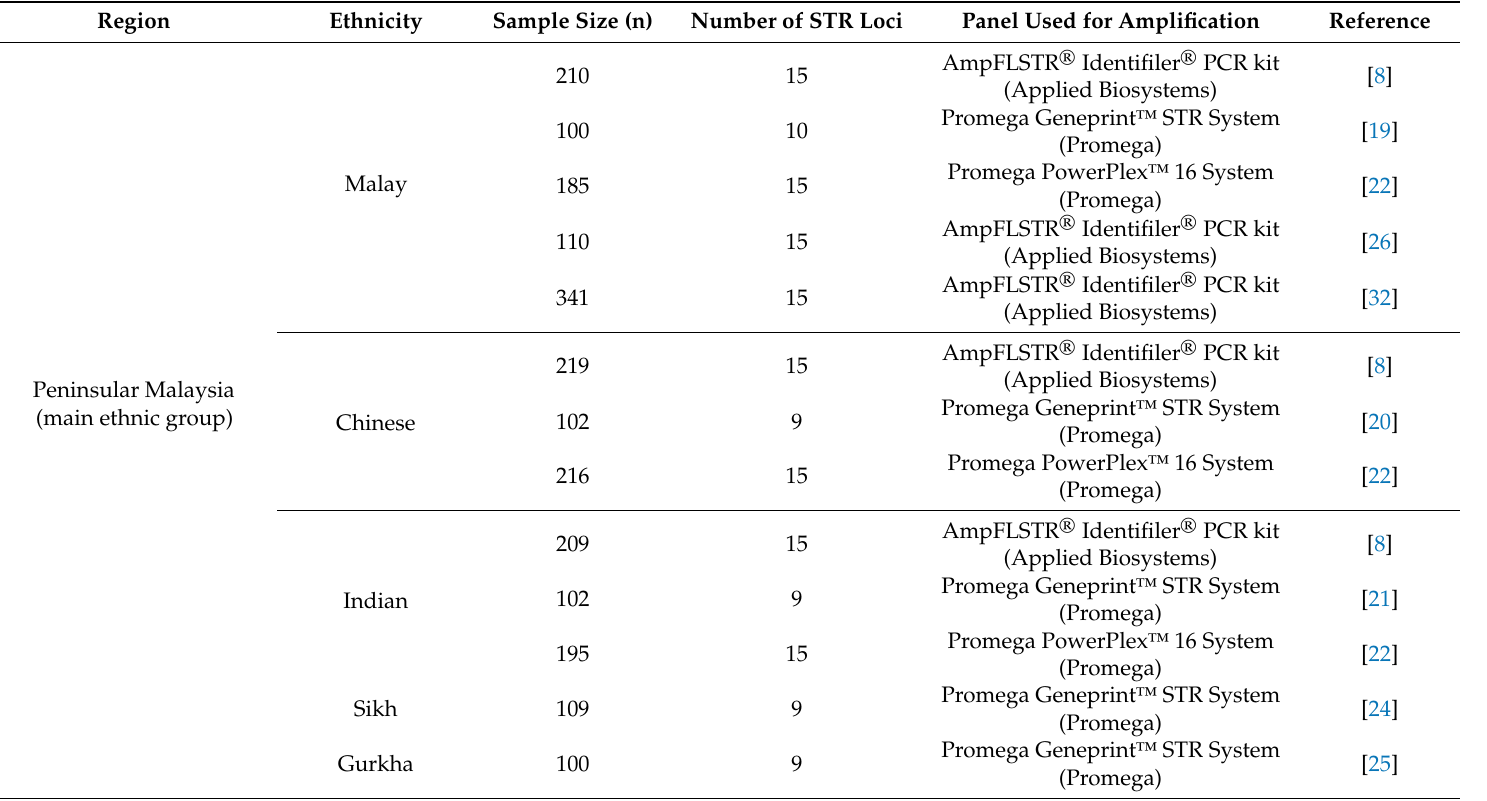
Table 3. List of autosomal STR studies in various population groups in